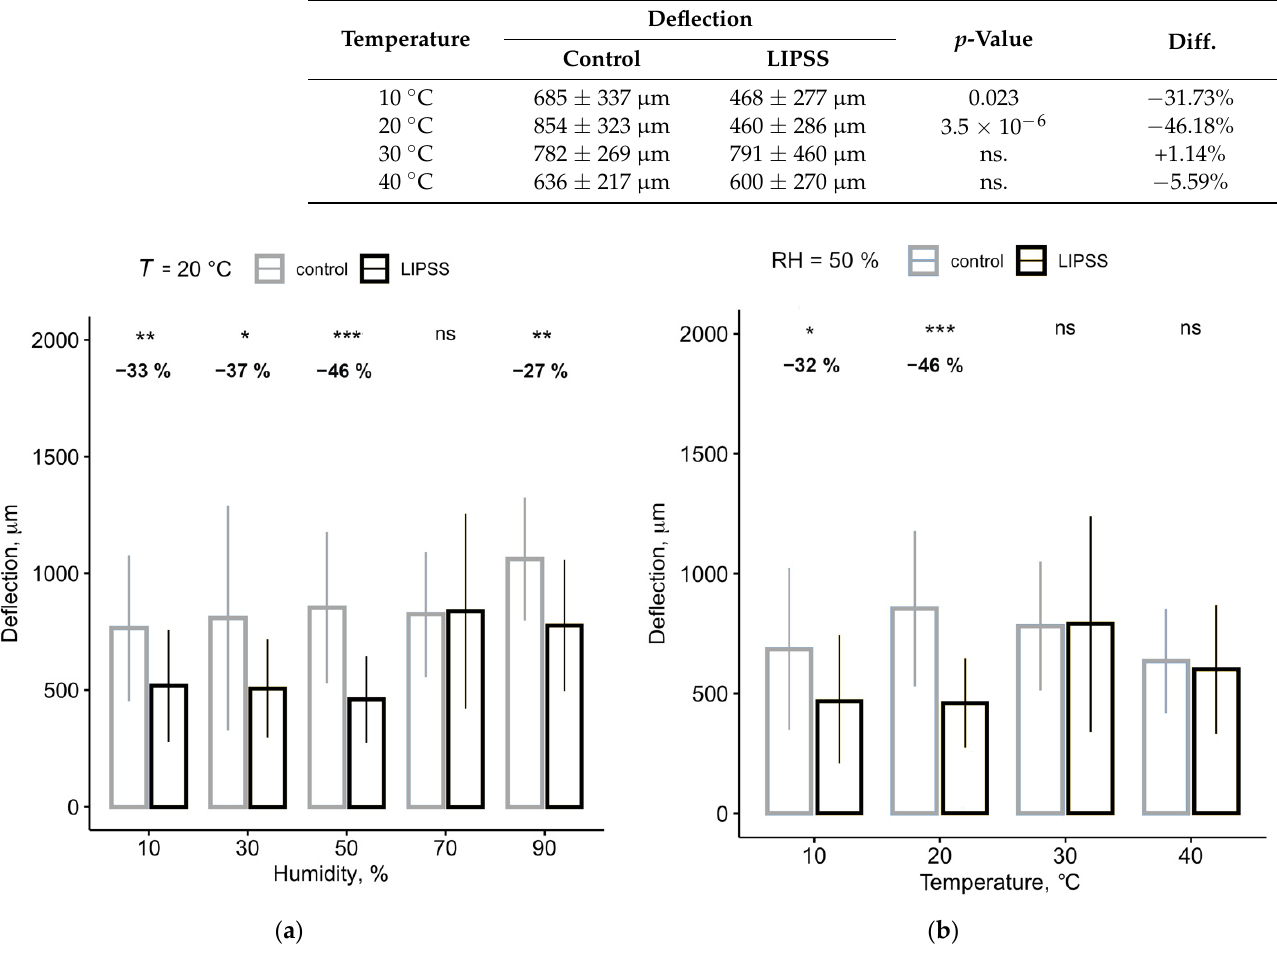
Table 1. Indirect measurement of the adhesion (by deflection) of the threads at different humidity levels, presented as mean ± SD and the relative change between control and structured surface (Diff.). Significance was calculated using a Wilcoxon t -test, with p < 0.05. Table 2. Indirect measurement of the adhesion (by deflection) of the threads at different temperature levels, presented as mean ± SD and the relative change between control and structured surface (Diff.). Significance was calculated using a Wilcoxon t -test, with p < 0.05.